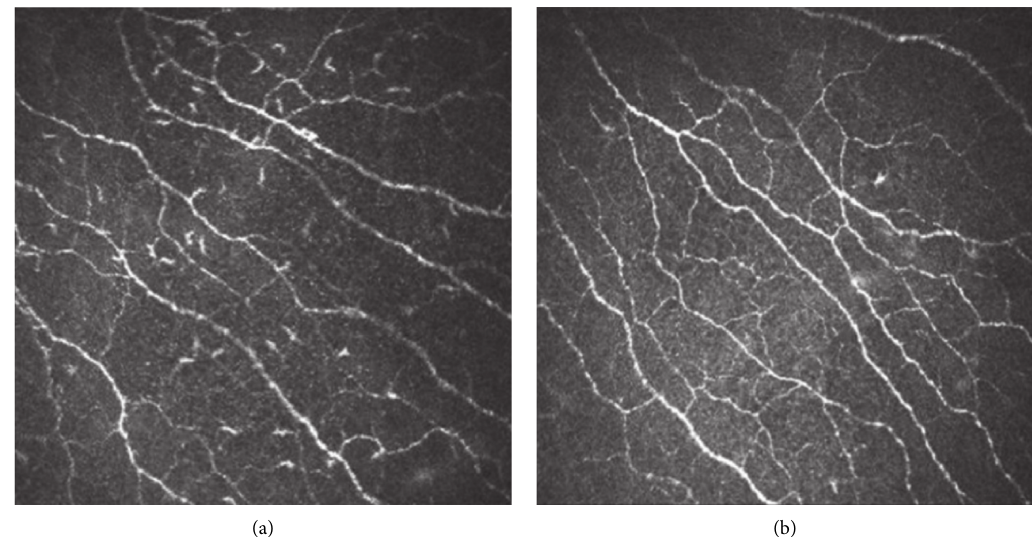
Figure 2: These two images are from the same corneal nerve layer of subepithelial corneal epithelium of the IVCM in the same patient in group 4: (a) before treatment; (b) 1 month after